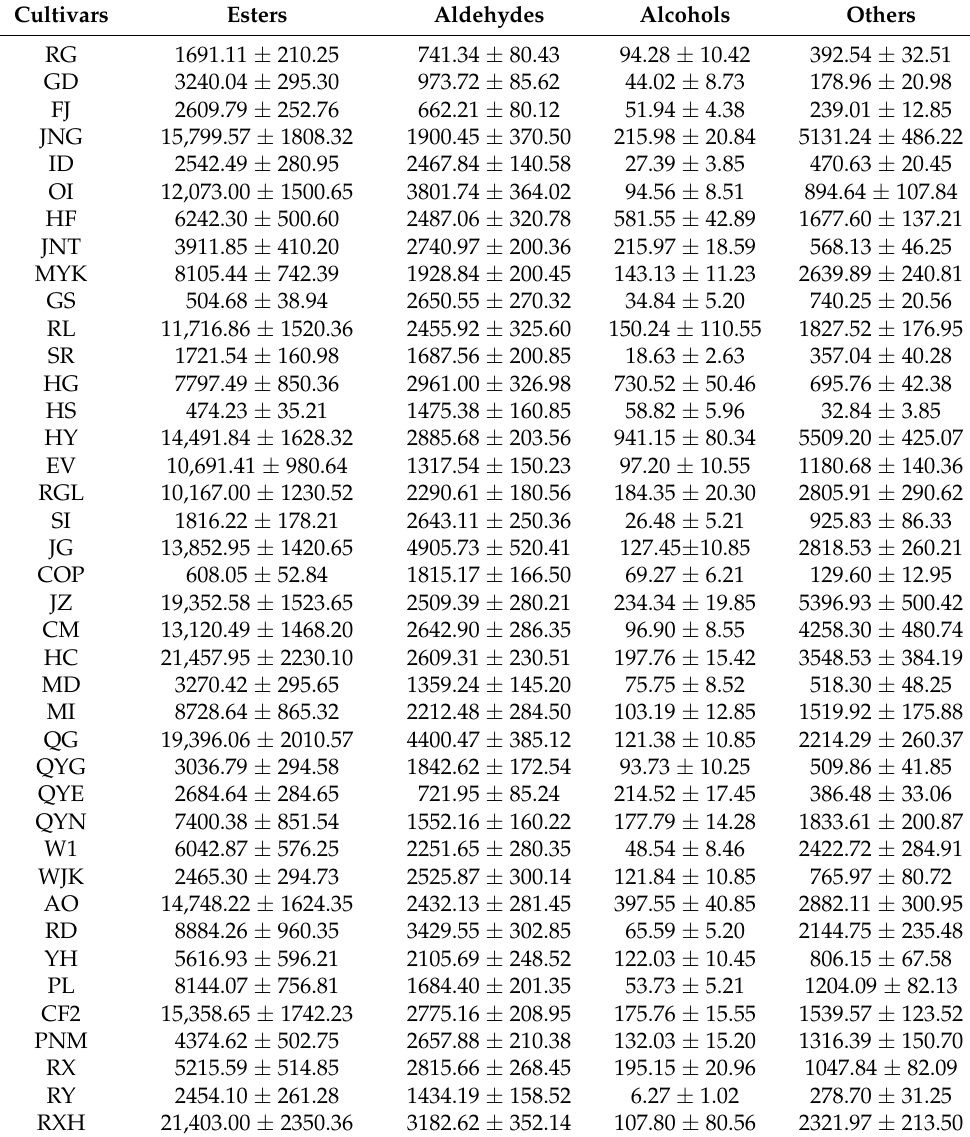
Table 4. The total content ( µ g/kg) of each type of volatiles in peels of 40 apple